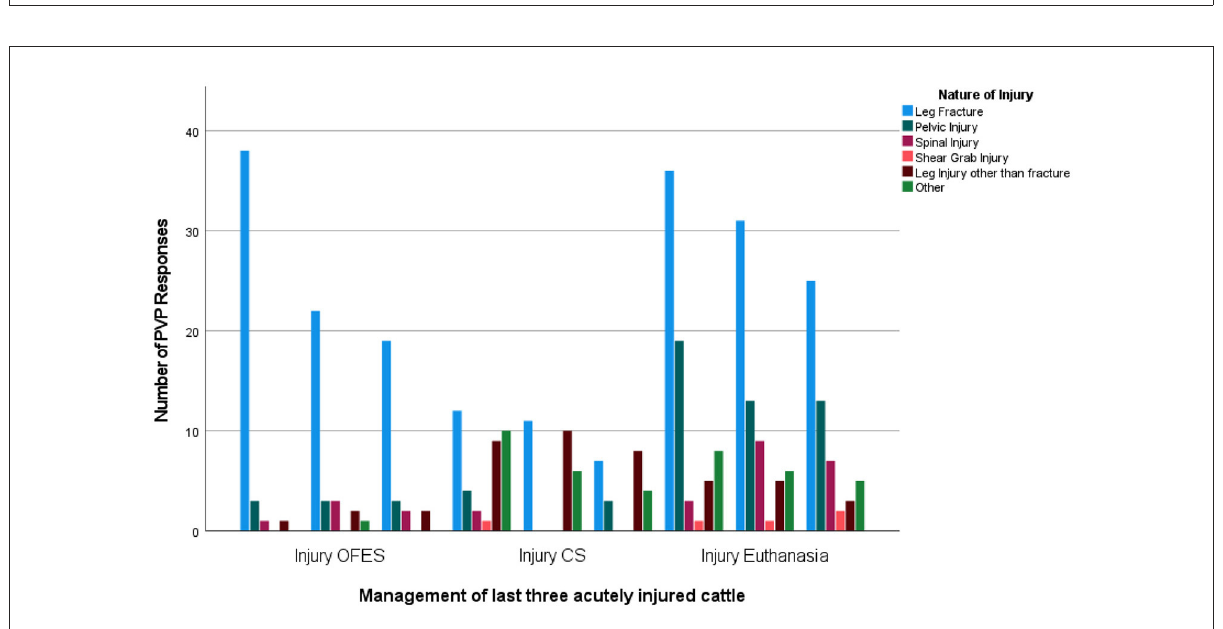
FIGURE2 The type of acute injury for the last three cattle resulting in on-farm emergency slaughter (OFES), casualty slaughter (CS) and euthanasia as reported by Private Veterinary Practitioners ( n = 72) in 2020.